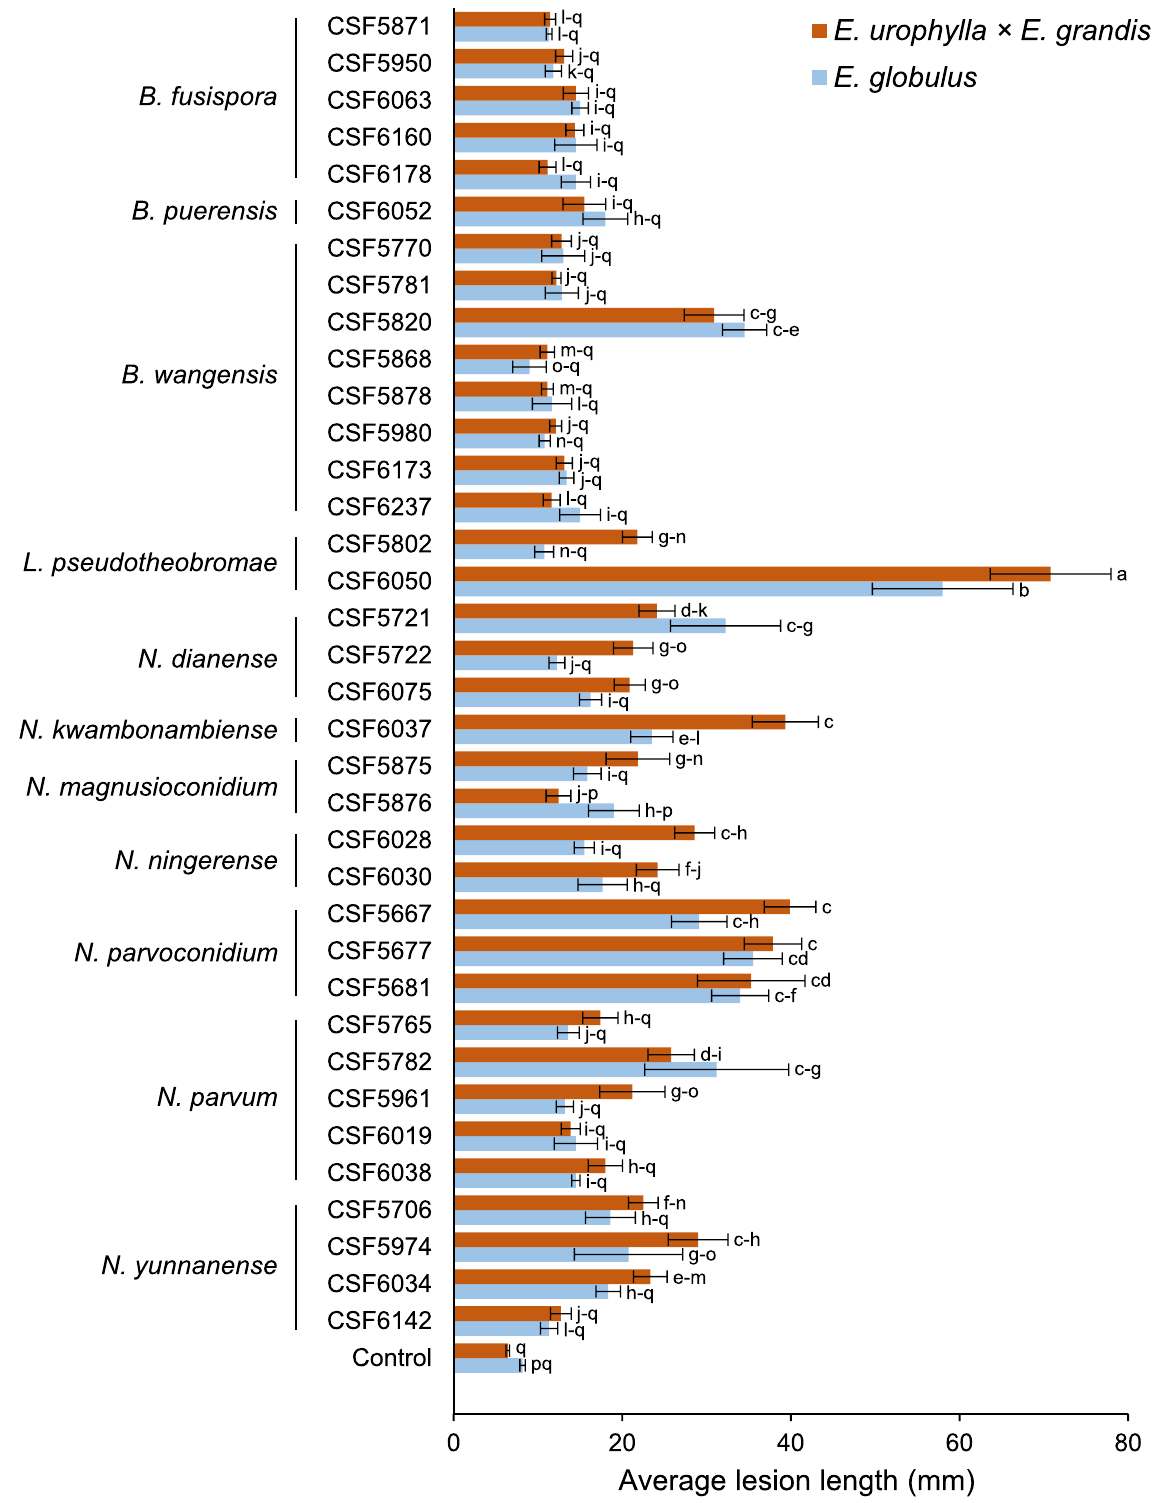
Fig. 12 Column chart indicating the average lesion length (mm) produced by 36 isolates of Botryosphaeriaceae on tested plants of E. globulus and E. urophylla × E. grandis . Horizontal bars represent standard error of means. Different numbers on the right of bars indicate treatment means that are significantly different ( P =